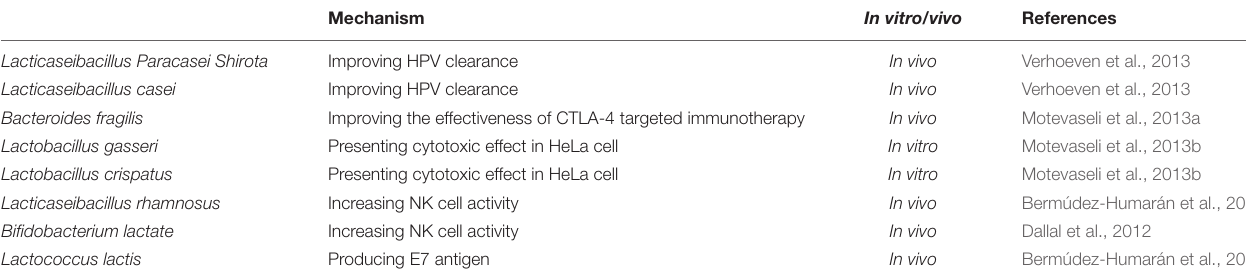
TABLE 1 | Therapeutic potential of probiotics based on microbiome and inflammatory in cervical